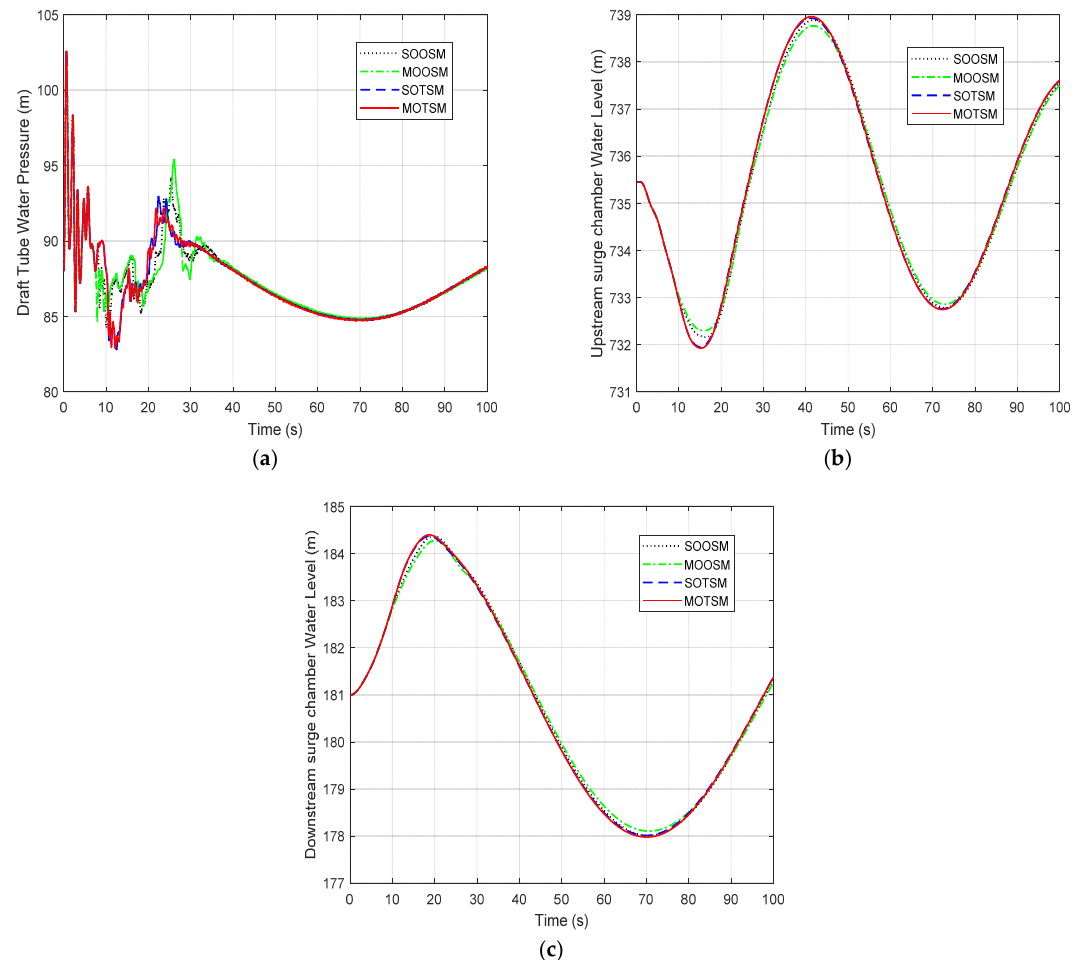
Figure 12. Some other transient processes of PSU with different solutions: ( a ) Draft tube water pressure of optimal solutions, ( b ) Upstream surge chamber water level of optimal solutions, ( c ) Downstream surge chamber water level of optimal solutions.